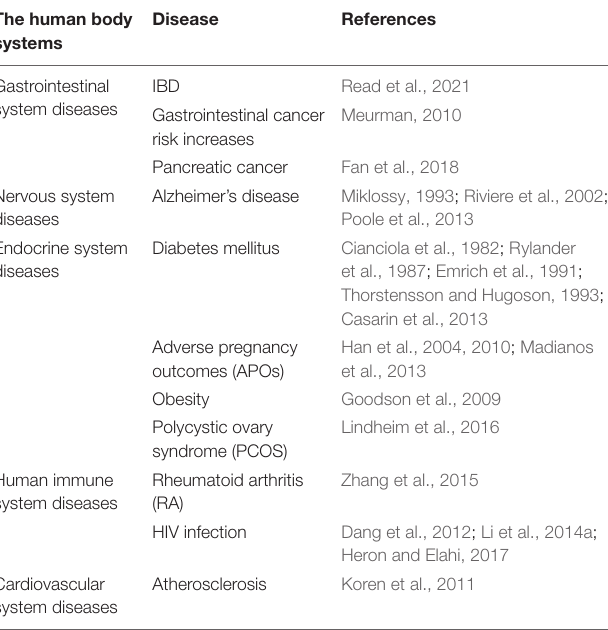
TABLE 3 | Systemic diseases associated with oral microbiome and orodental